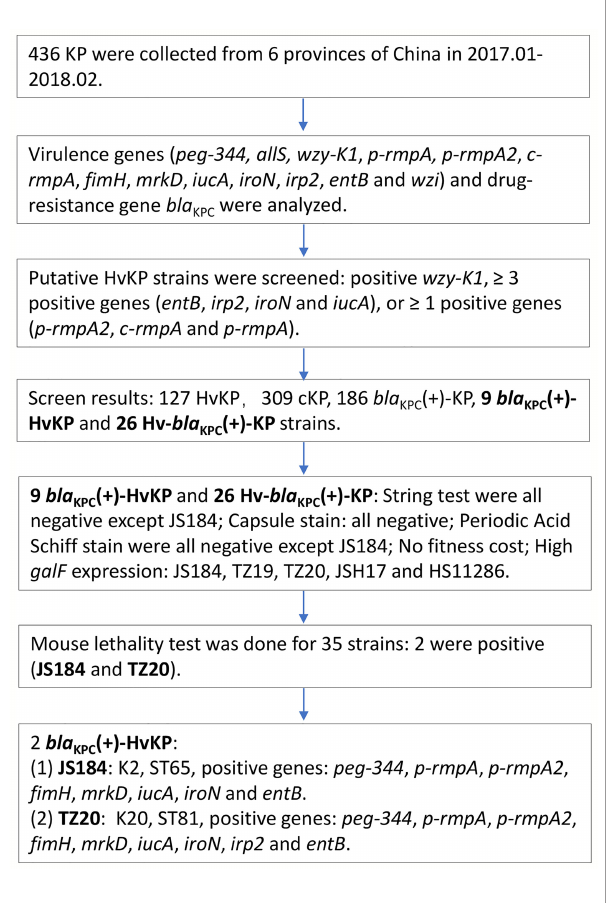
FIGURE 1 | Experimental methodology of the study. KP, Klebsiella pneumoniae ; HvKP, hypervirulent KP; bla KPC , beta-lactamase K. pneumoniae carbapenemase